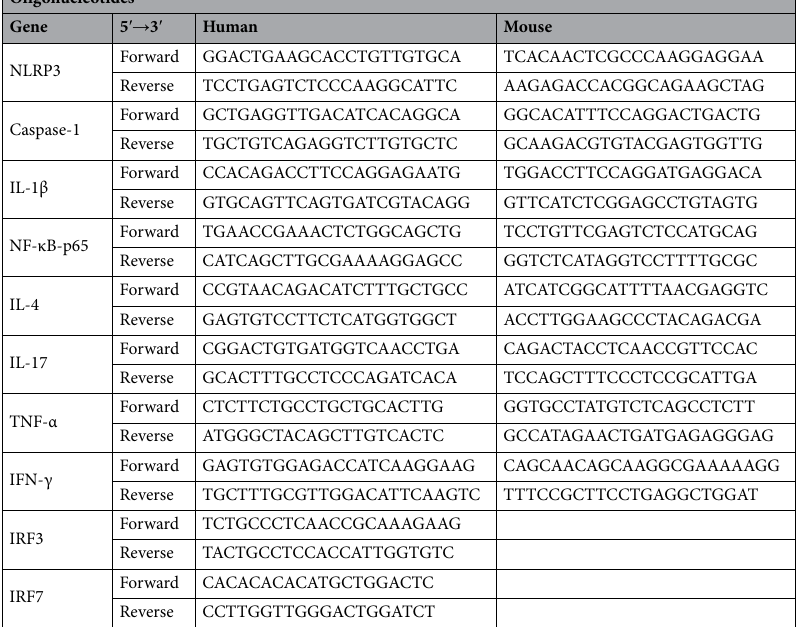
Table 1. Details of the oligonucleotide sequences for